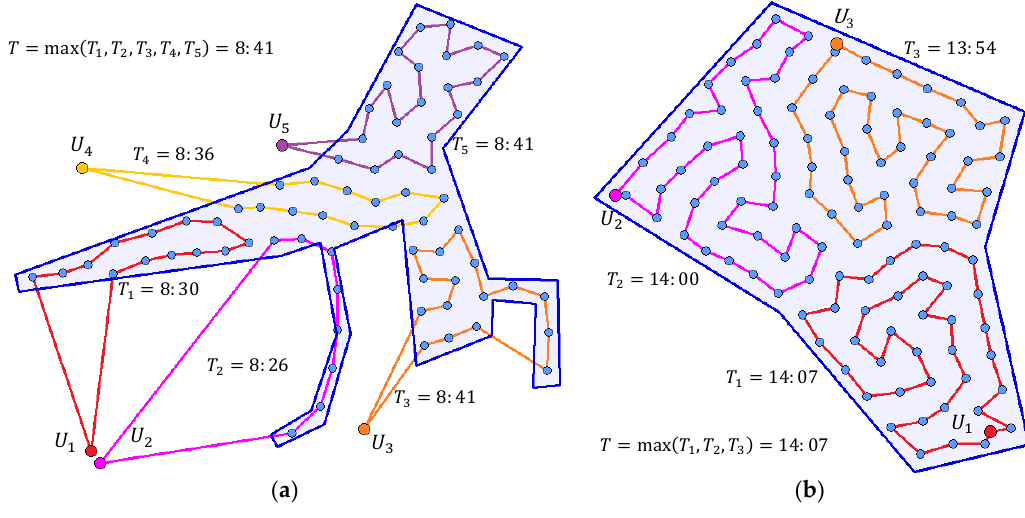
Figure 15. Planning the routes: ( a ) instance sc03; ( b ) instance sc04.